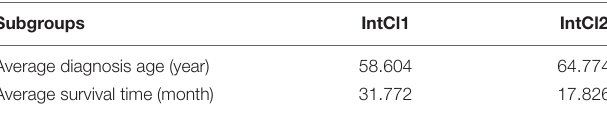
TABLE 3 | Average diagnosis ages and survival time of the BRCA patients in the integrative subgroups.